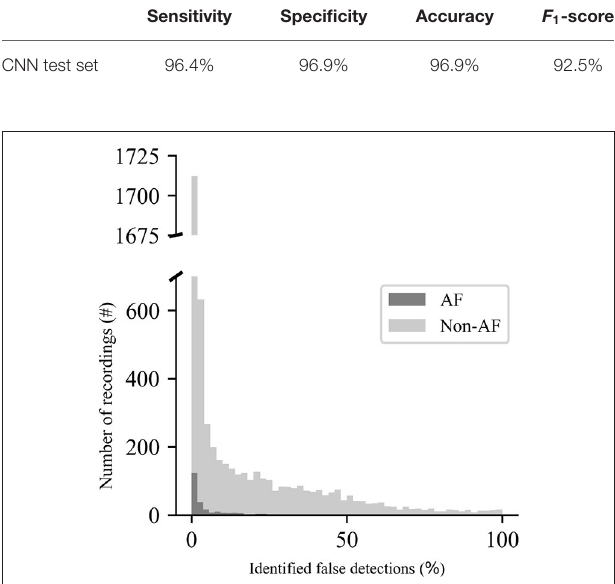
TABLE 5 | CNN performance on the test set.